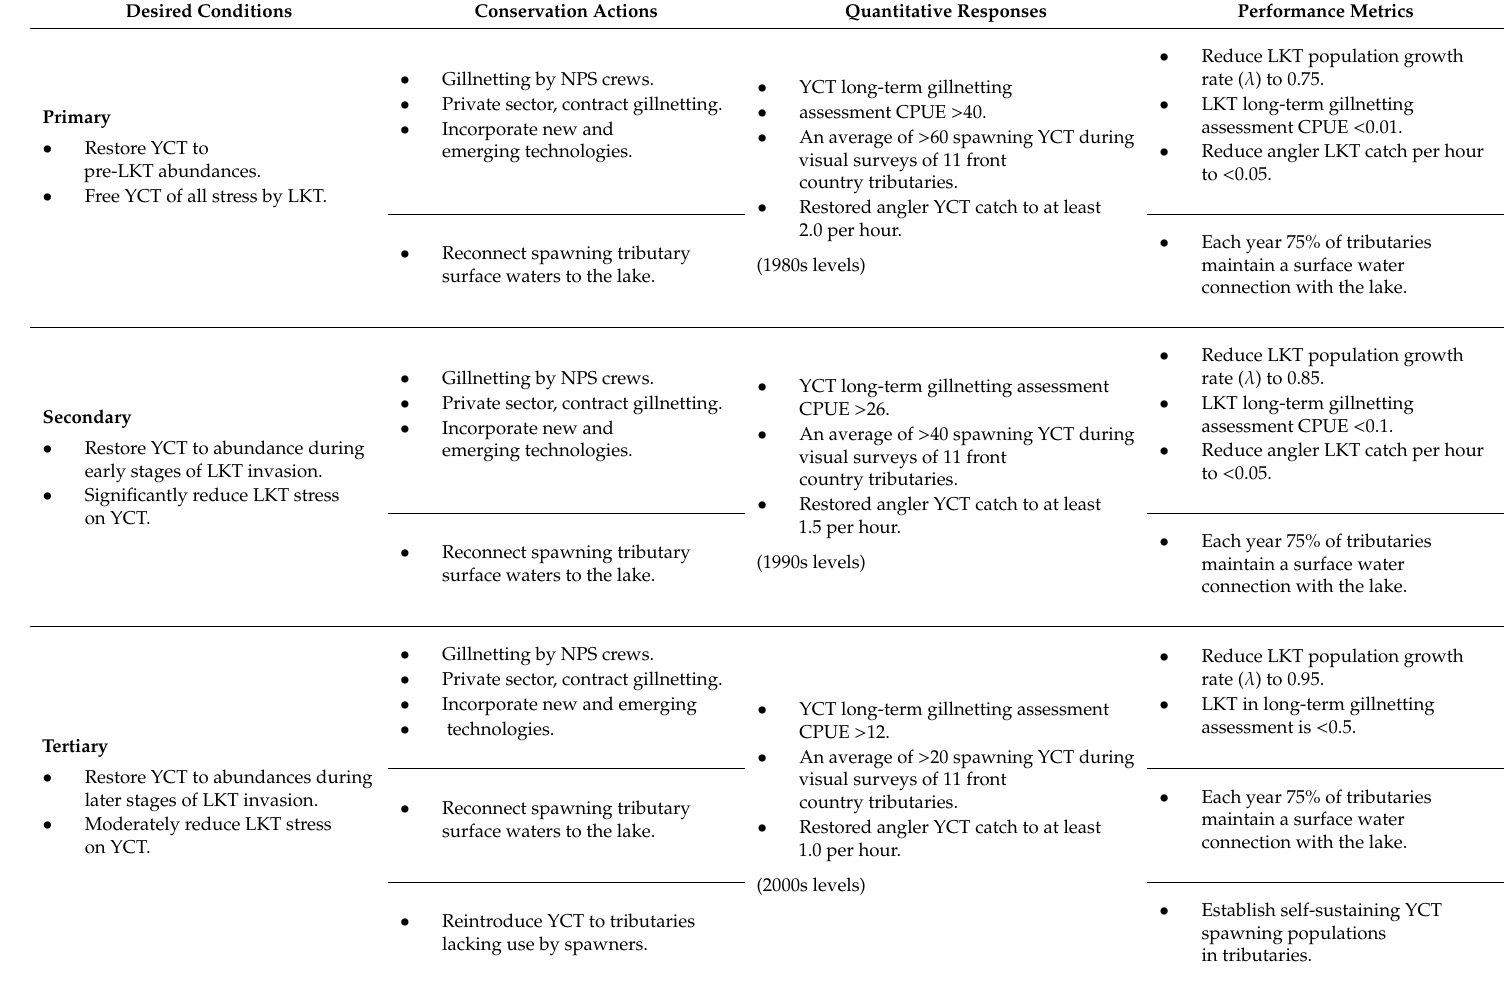
Table 1. Desired conditions, conservation actions, quantitative responses, and performance metrics for cutthroat trout (YCT) and lake trout (LKT) in the Yellowstone Lake ecosystem. Column labels A-D correspond to elements of the adaptive management strategy conceptual model (Figure